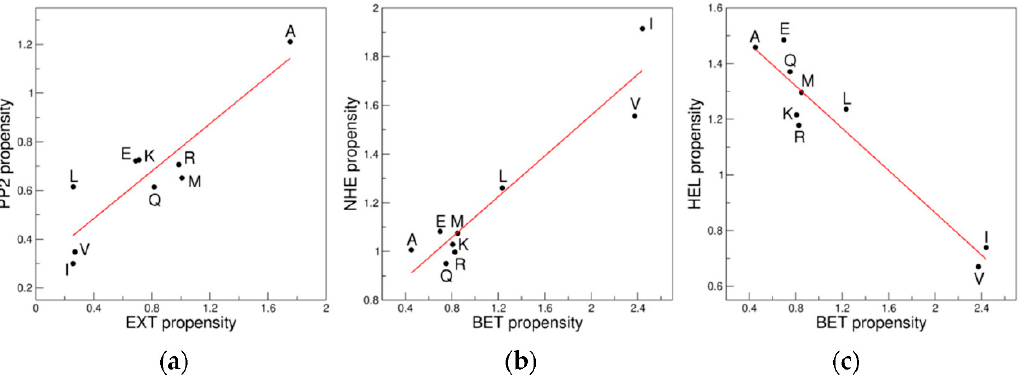
Figure 3. Examples of correlation/anticorrelations of the propensity scales of distant clusters: ( a ) EXT versus PP2; ( b ) BET versus NHE; and ( c ) BET versus HEL. The 9AA ensemble is considered.